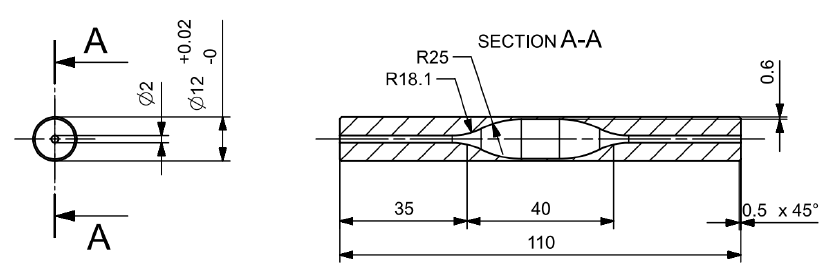
Figure 1. Geometry of samples [mm] made for experimental